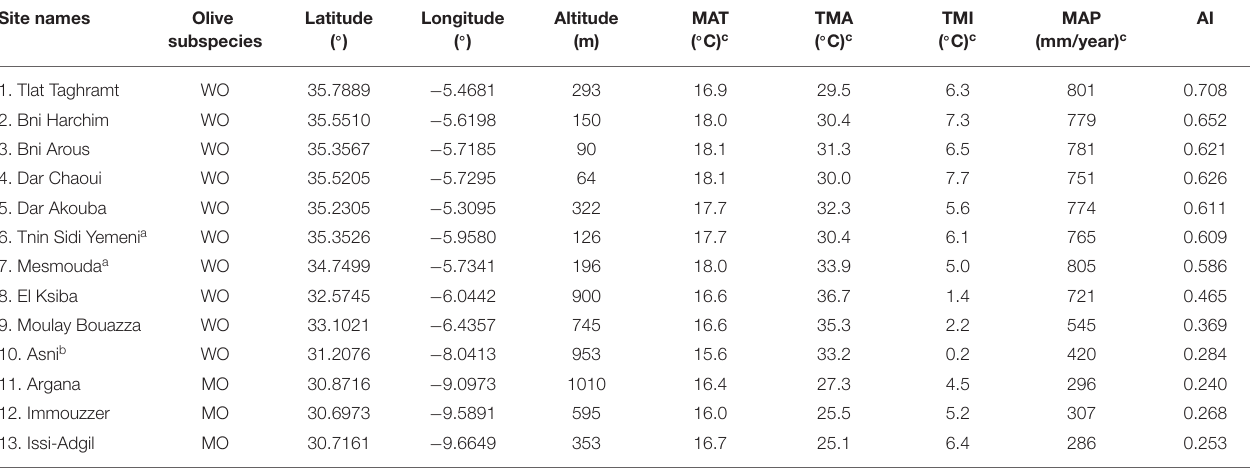
TABLE 1 | Geographical coordinates and mean climatic data of the sampled sites listed according to their subspecies affiliation and from north to south. Site names